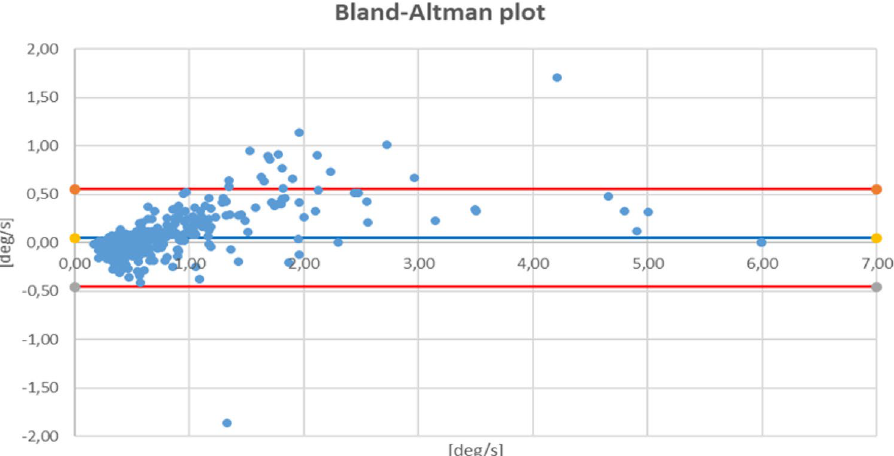
Figure 4. Bland–Altman plot for MediPost in relation to platform posturography results all subjects, lines represent differences expressed in terms of standard deviation (SD): red line: + 1.96 SD and − 1.96 SD.